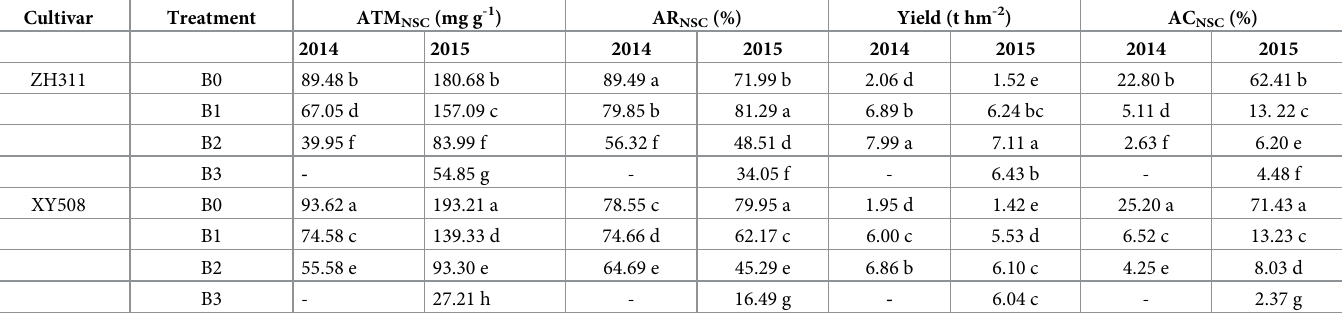
Table 5. Apparent transferred mass, apparent ratio of transferred, and apparent contribution of transferred NSC from the stems to grains under different nitrogen treatments. Cultivar